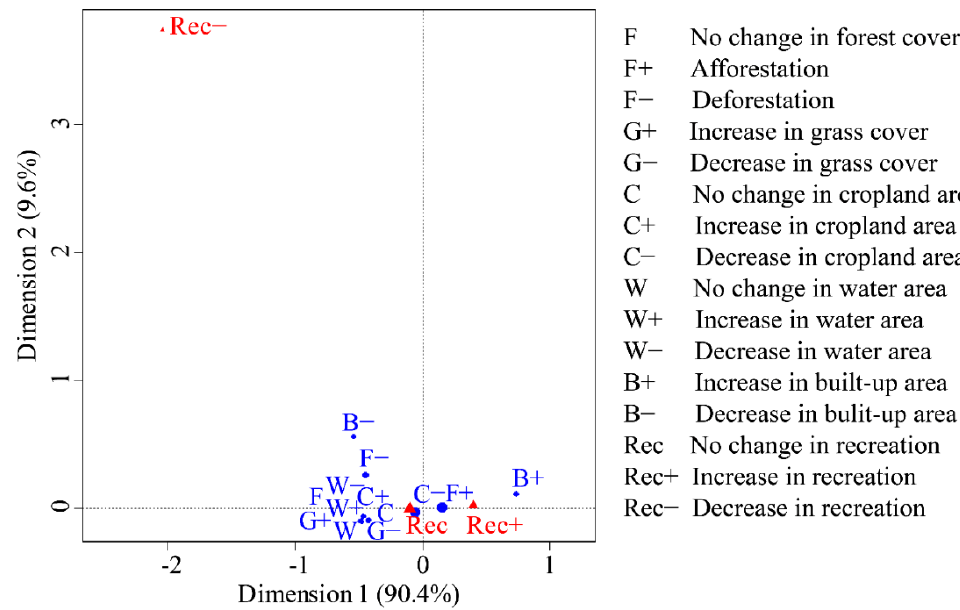
Figure 4. Correspondence analysis between recreation-service changes and land-use changes.